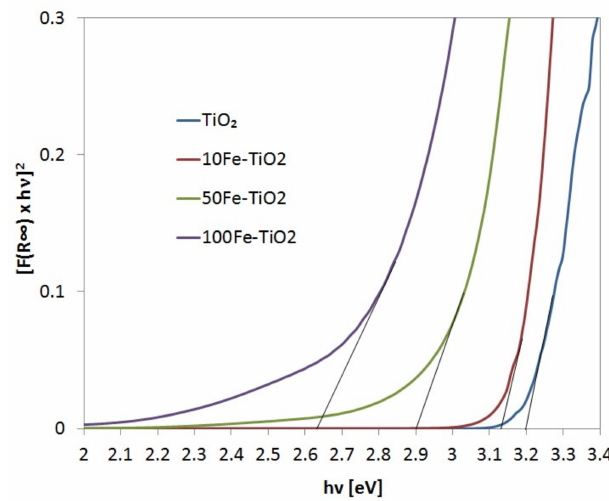
Figure 5. Band gap evaluation of for undoped and Fe-doped TiO 2 photocatalysts.